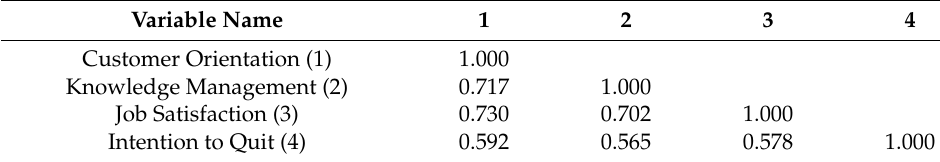
Table 4. Discriminant validity through average variance extracted